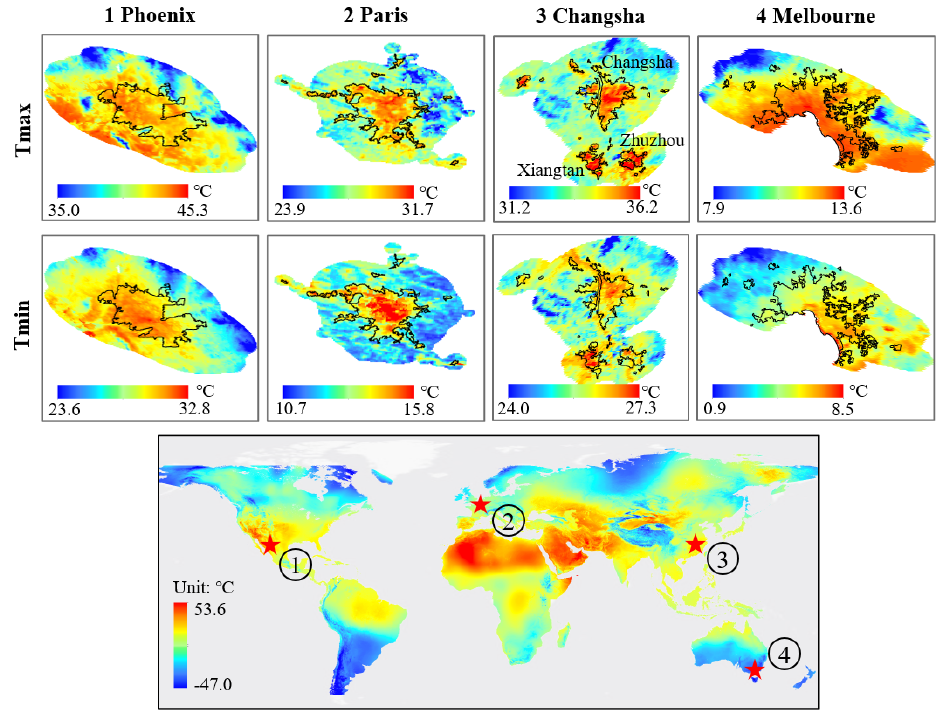
Figure 7. Spatial pattern of estimated T a in five representative cities on day 200 of the year 2010. A city shape includes the urban T a extracted by using nighttime light data (Zhou et al., 2018) and a surrounding buffer of equal size. Black polygons are the urban extents extracted by using global 30m resolution artificial impervious area data (Li et al.,